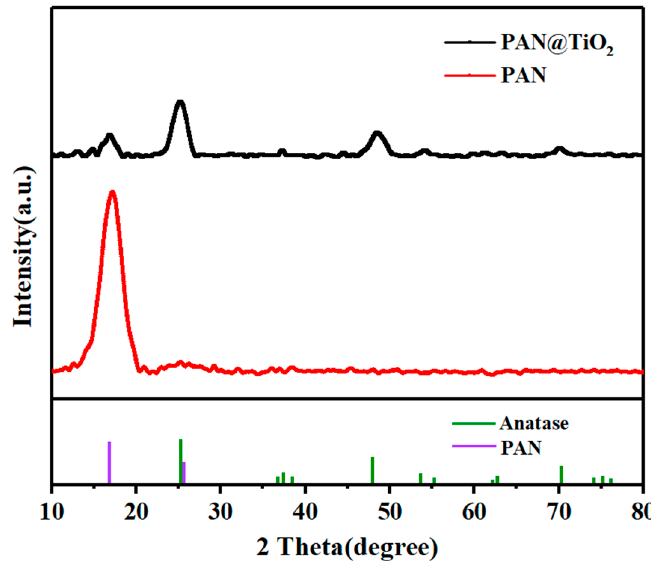
Figure 3. X-ray diffraction (XRD) patterns of PAN and PAN@TiO 2 nanofibers.